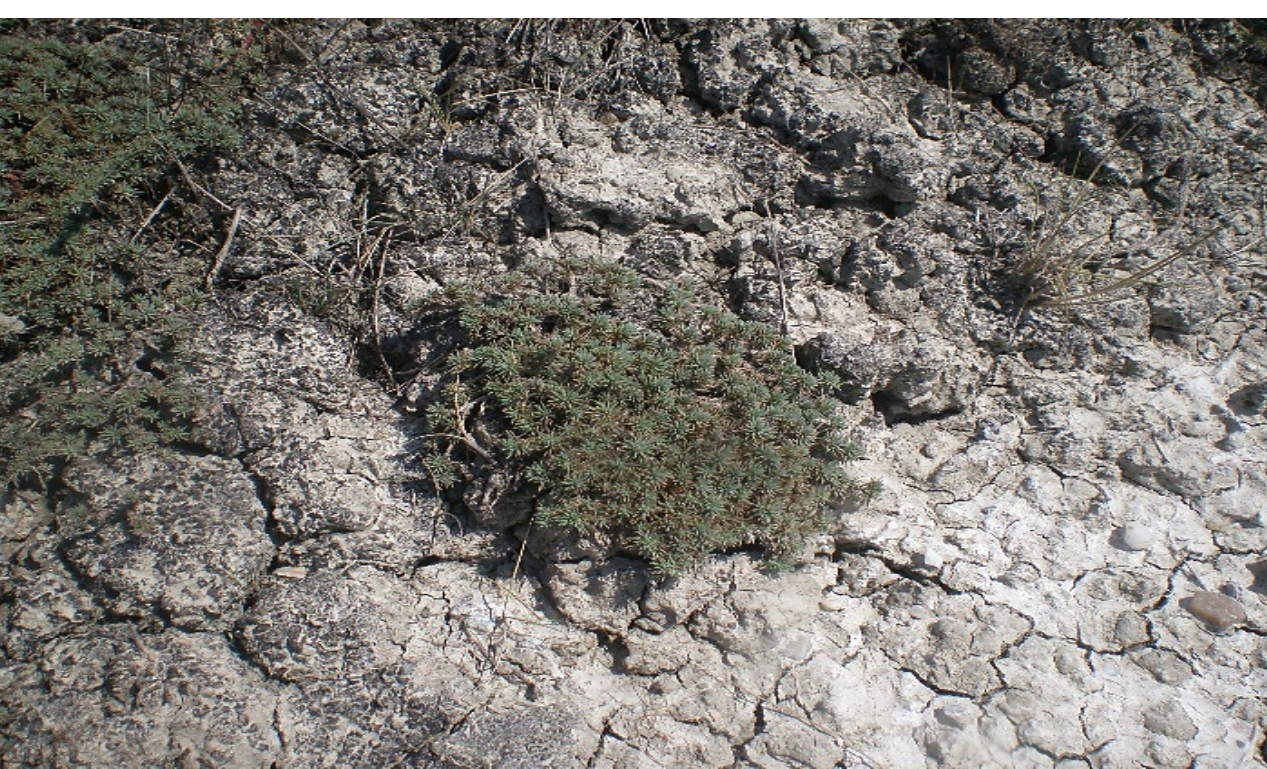
FIGURE 1 - Camphorosma monspeliaca